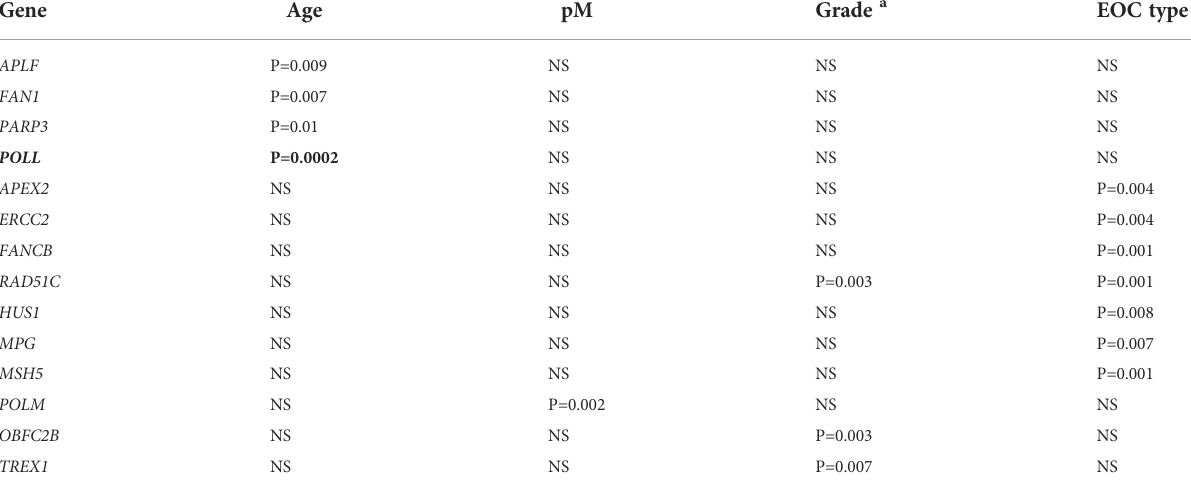
TABLE 3 Associations of whole DNA repair gene methylation pro fi le with clinical data of EOC patients (N=73, only signi fi cant result with P ≤ 0.01 are listed).